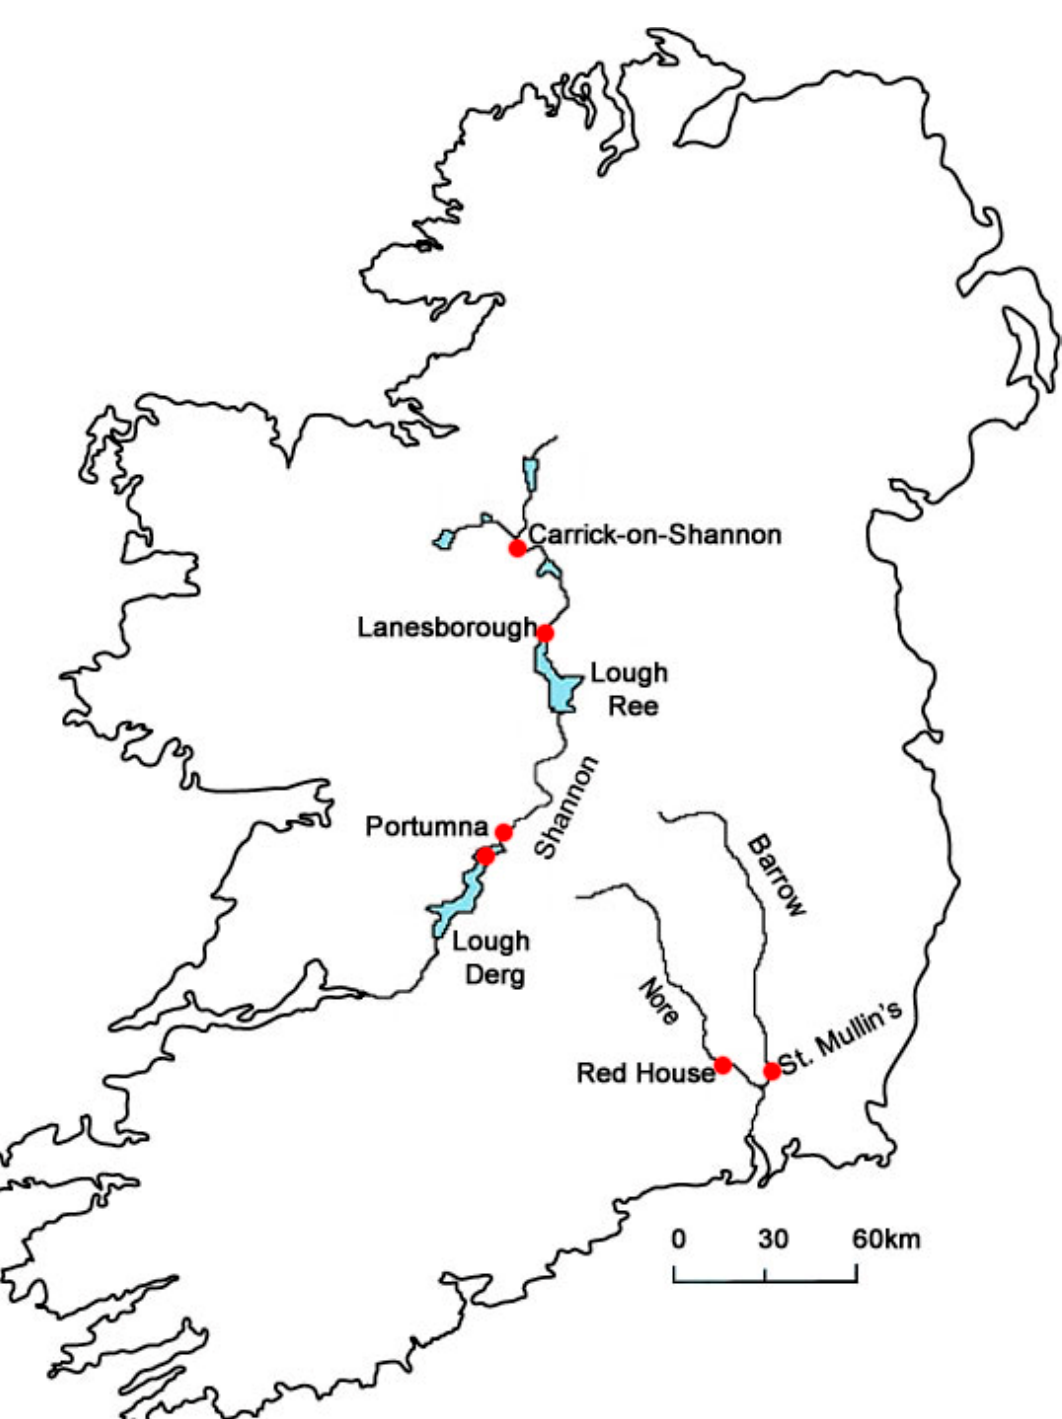
Figure 1. Irish rivers containing Corbicula specimens, previously described as C. fluminea , sampled during this study, River Nore, Barrow and Shannon. Sampling sites Carrick-on-Shannon, Lanesborough, Portumna, Lough Derg, St. Mullin’s and Red House.